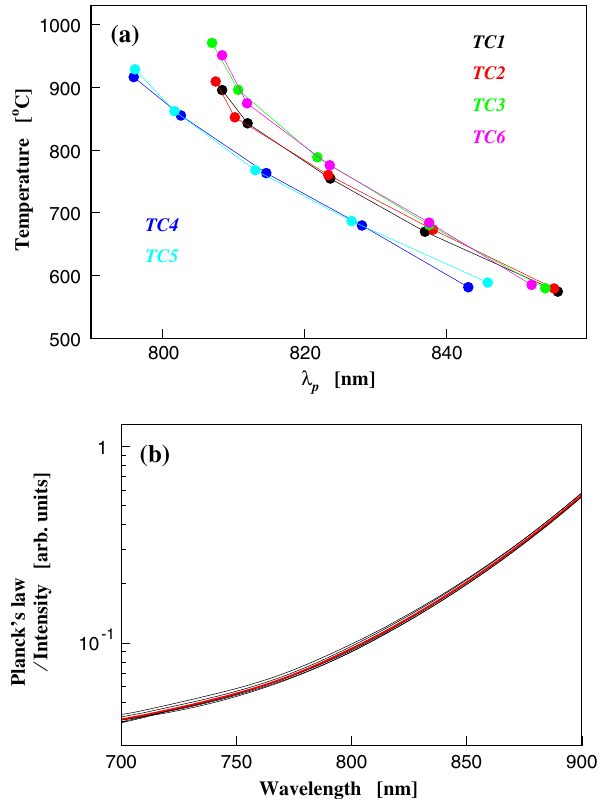
FIG. 14. Results of the thermal radiation measurement. (a) Tem- peratures of the thermocouples plotted against the peak positions in the thermal radiation spectra. The six thermocouples (TC1 – TC6) are shown in Fig. 13(a). (b) Correction factor to convert observed spectra to physical spectra. The plot contains eight black curves, which correspond to the data for TC4 and TC5 at the four temperatures above 600 °C shown in (a). The red curve is the average of the eight black